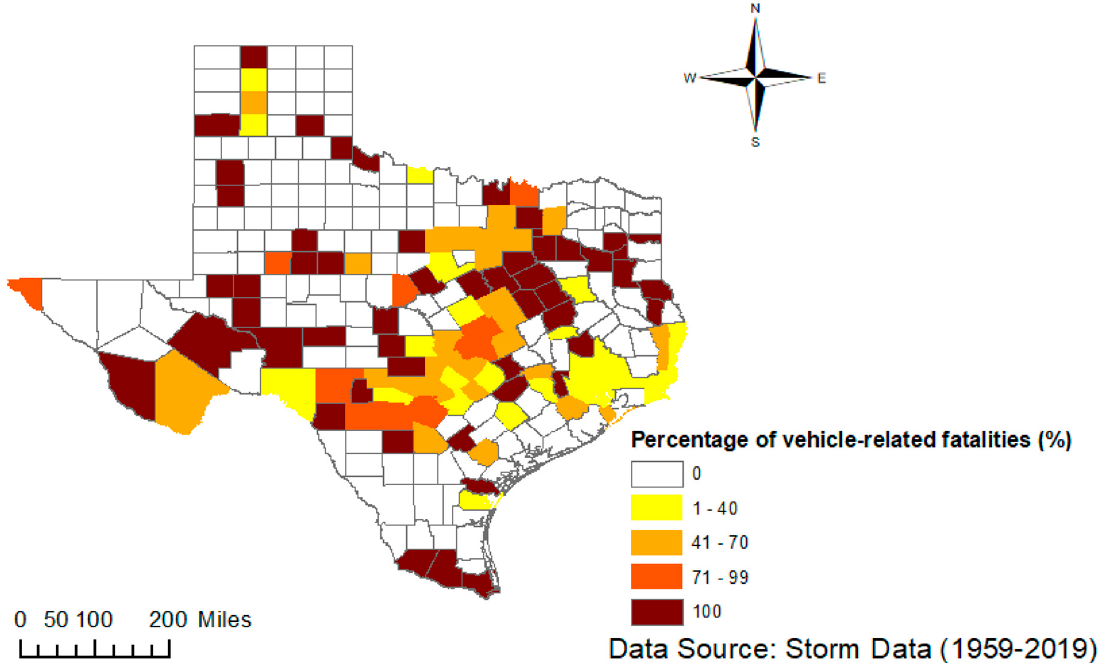
Figure 11. The proportion of vehicle-related flood fatalities in total flood fatalities by county in Texas, 1959–2019.